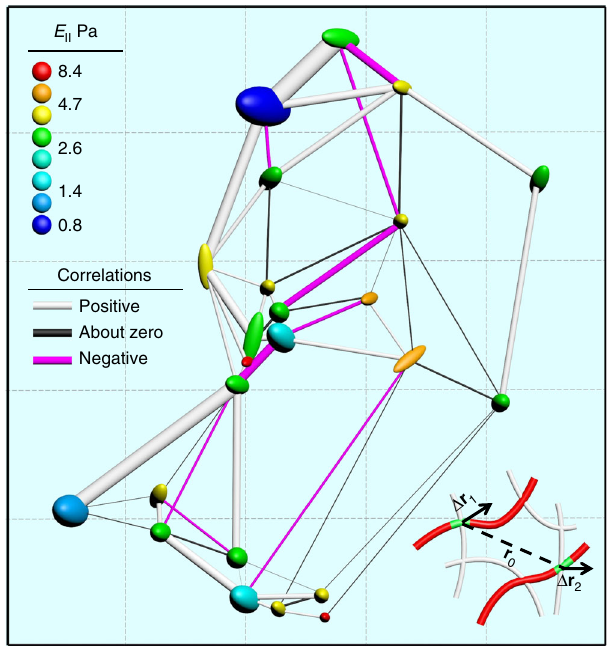
Fig. 3 A spatial map of fl uctuations, local elasticity, and correlations between crosslinks. In this 42 × 45 μ m view, the fl uctuation bulbs are sized according to b (enlarged 50 times) and color coded by E ║ . The connecting lines denote cross-correlations ( C rr ) with their widths and color representing magnitudes and signs. The connected crosslinks are not necessarily neighbors, there could be many unlabeled crosslinks in between them. Massive heterogeneity and negative lines of moderate magnitude are noteworthy. The inset shows crosslinks 1 and 2, which are r 0 apart and experience displacements of Δ r 1 and Δ r 2 during an elapsed time. C rr is de fi ned as the product of the projected displacements (on the r 0 vector) (cid:4) < Δ r Δ r > . Please note ensemble-averaged over many time steps, C 1 ; r 2 ; r rr that this map was measured and constructed in